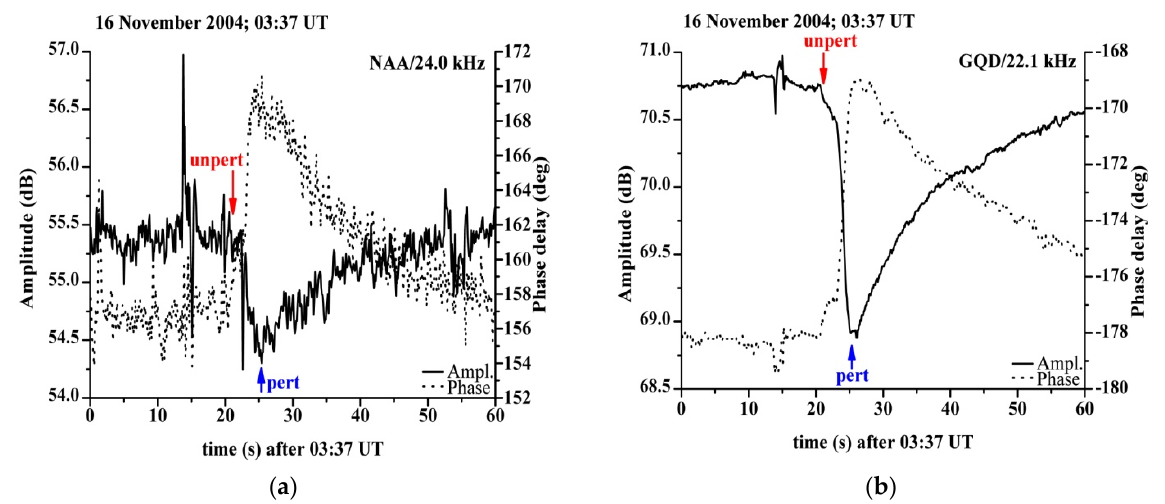
Figure 4. Amplitude (solid lines) and phase delay (dotted lines) time evolution before and during the LEP event occurred on 16 November 2004 on considered VLF signal traces: ( a ) NAA/24.0 kHz and ( b ) GQD/22.1 kHz.